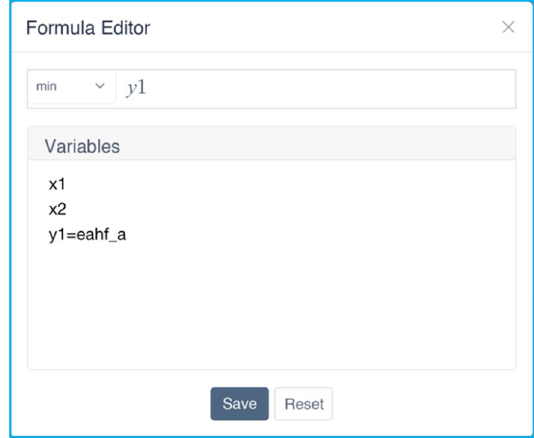
Figure 17 The formula editor in DADOS